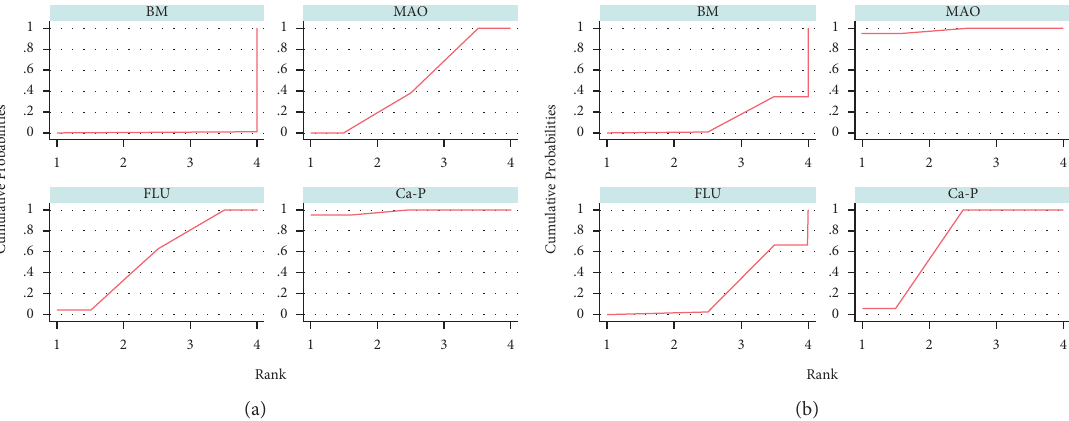
Figure 12: Plot of surface under cumulative ranking curves for all treatments: (a) % degradation and (b) new bone.